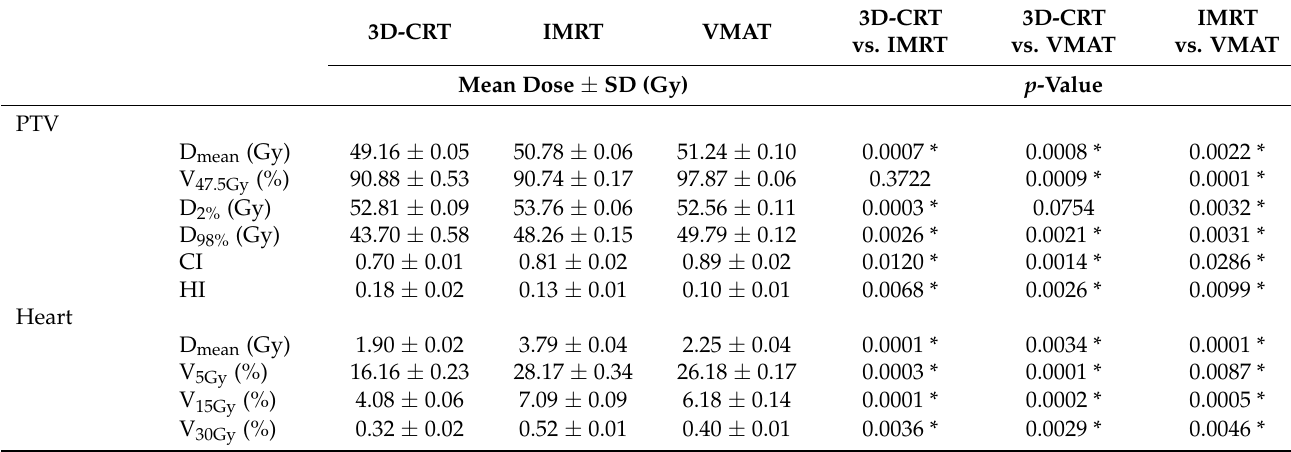
Table 1. Comparison of PTV and heart dose-volume histogram (DVH) parameters in three different treatment plans. 3D-CRT